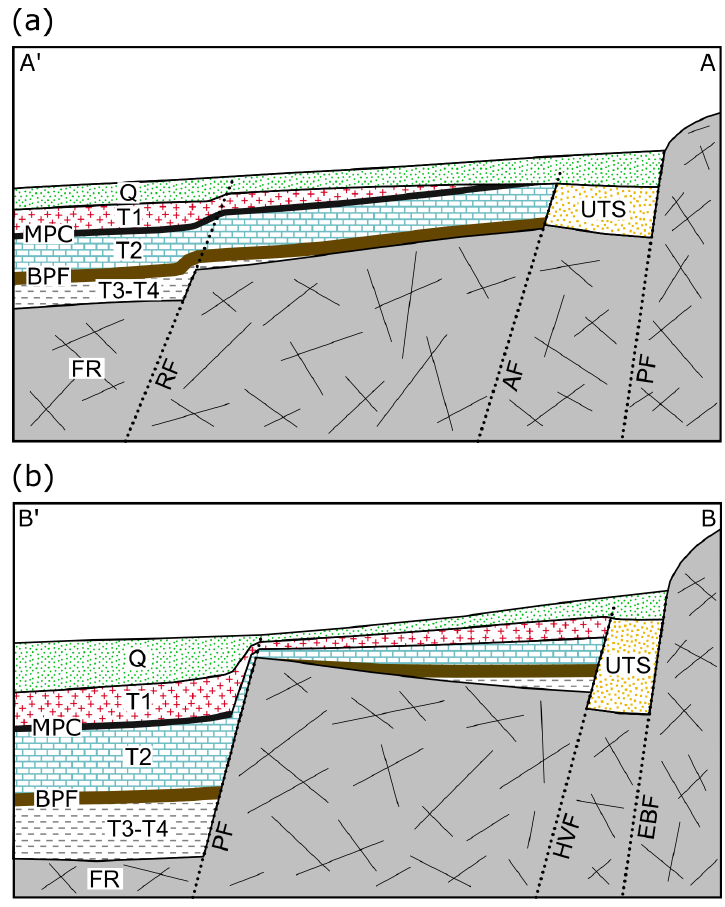
Figure 7. Schematic hydrogeological cross sections in (a) the NAP and (b) the CAP sub-basins (see Fig. 2) (after Shepherd, 1975; Gerges, 1999; Zulfic et al., 2008; Baird, 2010). Q: Quaternary aquifers (lumped together; in reality there are up to six different aquifers depending on location, separated by clay layers); T1, T2, T3 and T4: Tertiary aquifers; UTS: undifferentiated Tertiary sand aquifers; MPC: Munno Para clay aquitard; BPF: Blanche Point Formation aquitard; FR: fractured-rock aquifers; RF: Redbank Fault; AF: Alma Fault; PF: Para Fault; HVF: Hope Valley Fault; EBF: Eden–Burnside